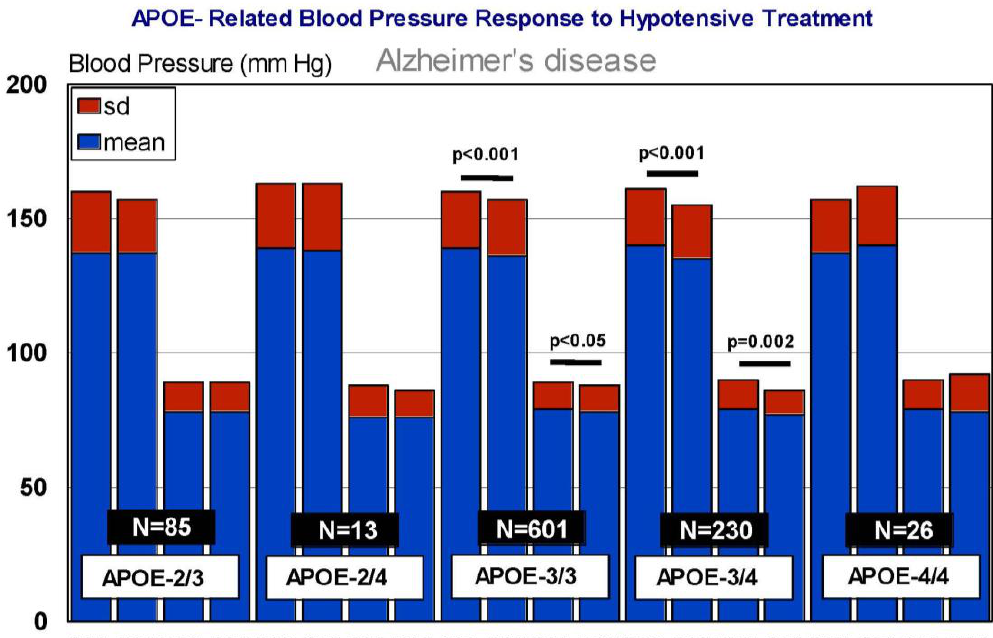
Figure 14. APOE -related blood pressure response to a hypotensive treatment. SBPb: Systolic blood pressure. SBPt: Systolic blood pressure (Enalapril, 10–20 mg/day). DBP: Diastolic blood pressure.